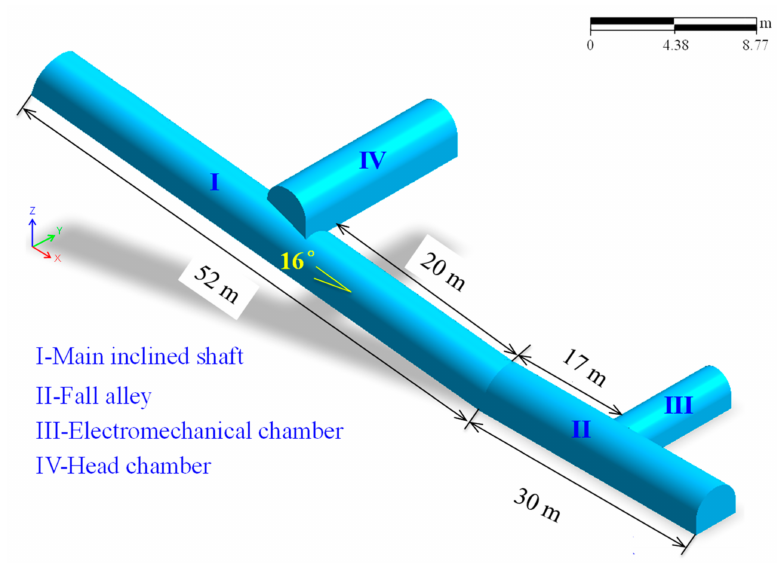
Figure 2. Geographical location of the